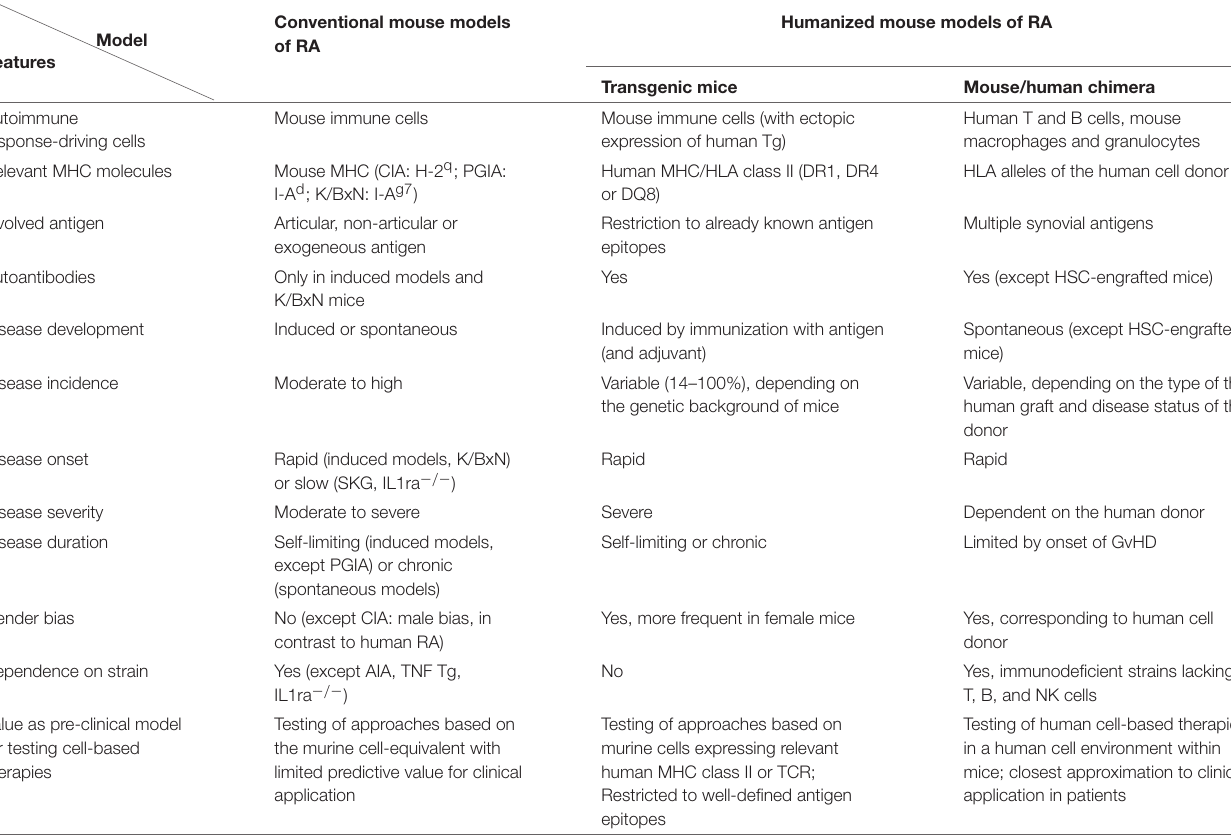
TABLE 1 | Comparison between conventional and humanized mouse models of rheumatoid arthritis.